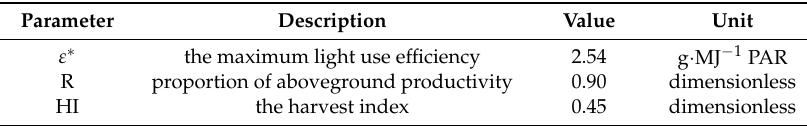
Table 3. The parameters used to estimate wheat biomass and yield.